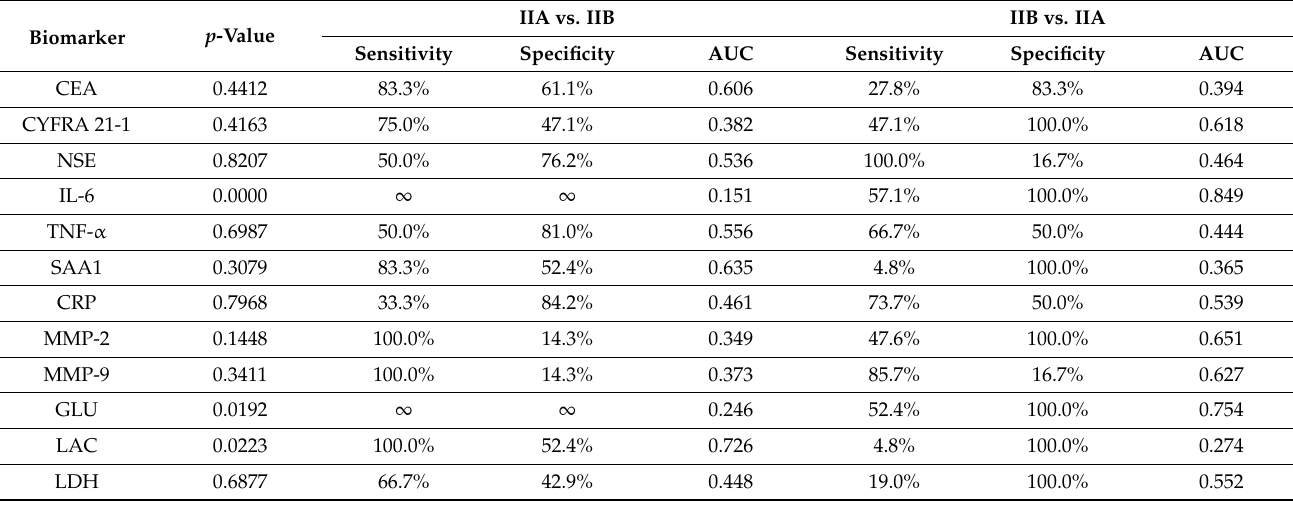
Table 8. The diagnostic efficiency of single biomarkers to distinguish patients with stage IIB and IIA lung cancer. Biomarker